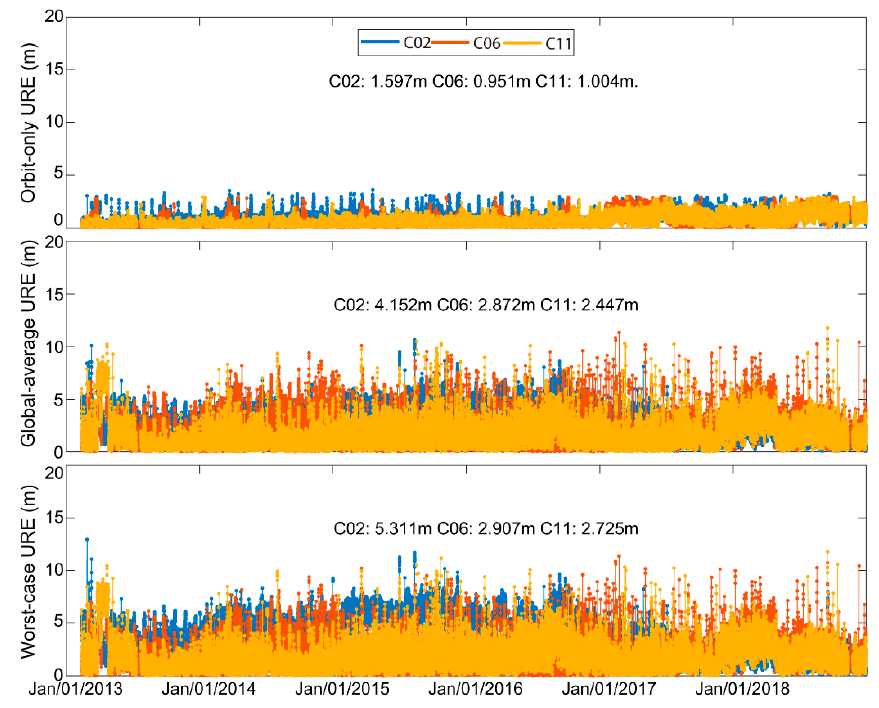
Figure 7. Six-year C02/C03/C11 orbit-only user range errors (UREs), global-average UREs, and worst-case UREs.